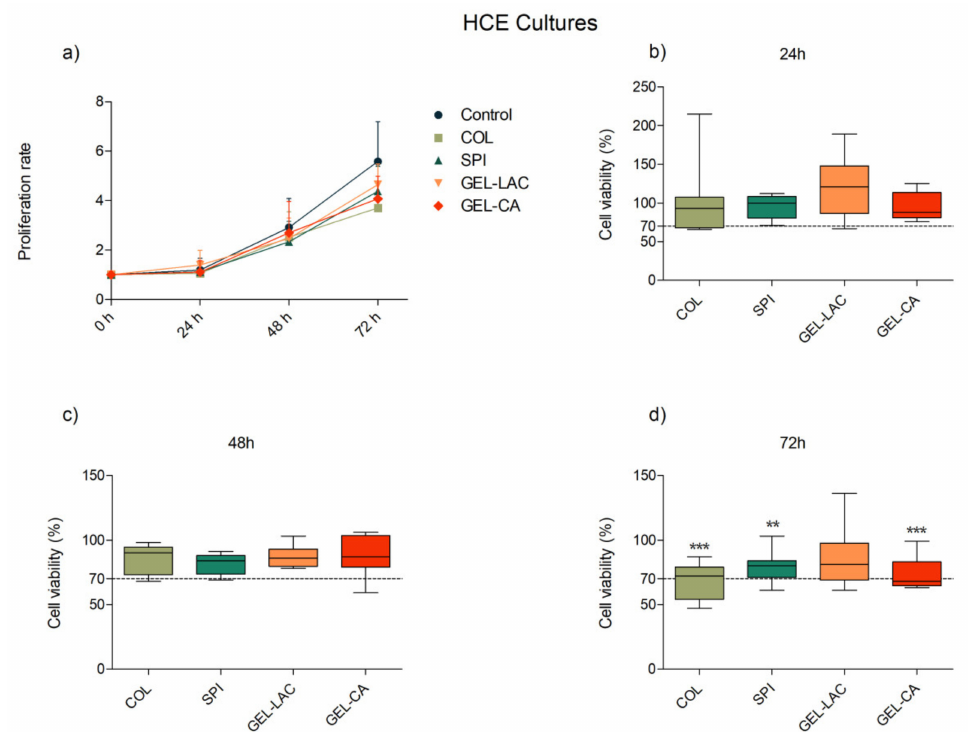
Figure 5. Effects of film composition on the ( a ) proliferation and ( b – d ) viability of human corneal epithelial (HCE) cells. Cells seeded in p96-well plates were exposed to each film for 24, 48, and 72 h. Cells seeded on wells without any biomaterial were used as controls. Proliferation results are represented as proliferation rate mean ± SD of viable cells compared with viable cells at t = 0 h. Viability results are expressed as percentages of viable cells in relation to control wells (100% viability). The lines drawn inside each box represent the medians of viability values of each film. Statistically significant differences showed differences with respect to control (* p < 0.05, ** p < 0.01, *** p < 0.001; n =